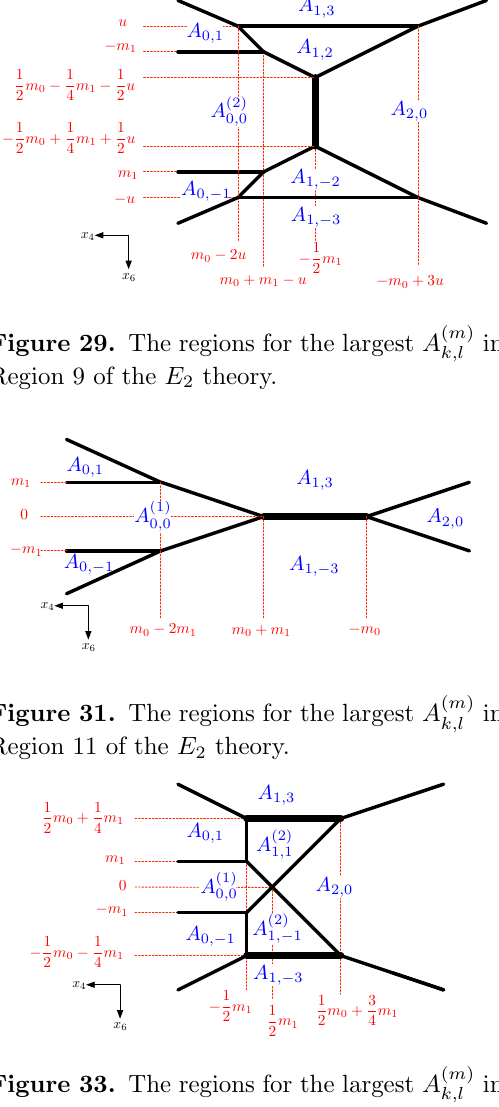
in Figure 34. The regions for the largest A ( m ) k;l Region 14 of the E 2 theory.